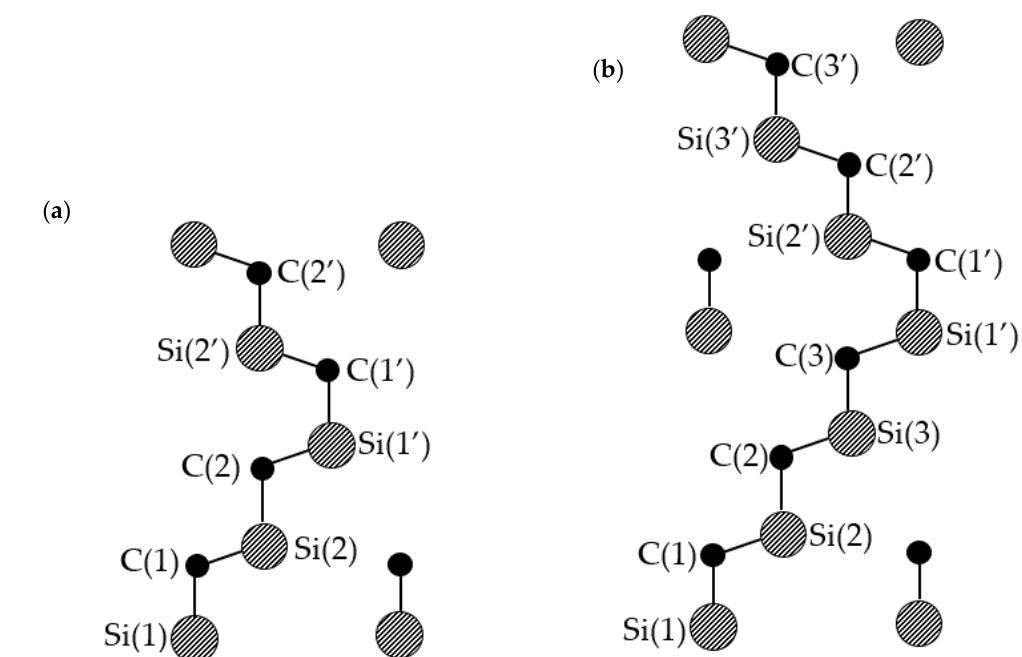
Figure 5. Lattice structures of ( a ) 4H-SiC and ( b ) 6H-SiC. Where in both cases the Si(1)-C(1) and Si(1 ′ )-C(1 ′ ) bonds are hexagonal and the rest are cubic in nature. The C atoms are solid black and the Si atoms are hashed. Table 2. Distances between Si and C layers in wurtzite 4H-SiC and 6H-SiC lattices in angstroms relative to the c-axis in Figure 6.